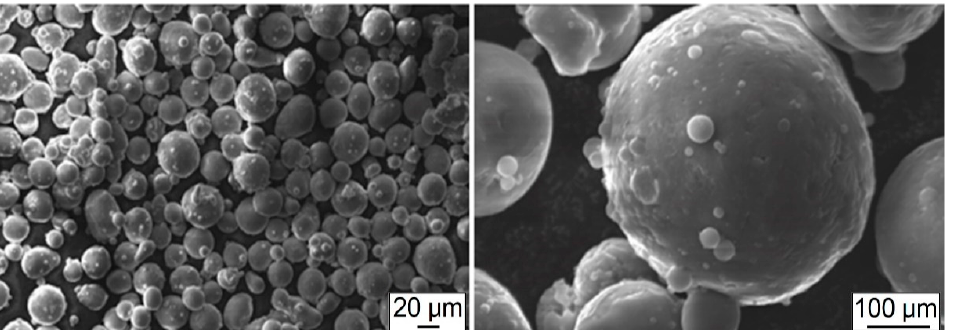
Figure 1. SEM images of the AlSi10MgCu powder.